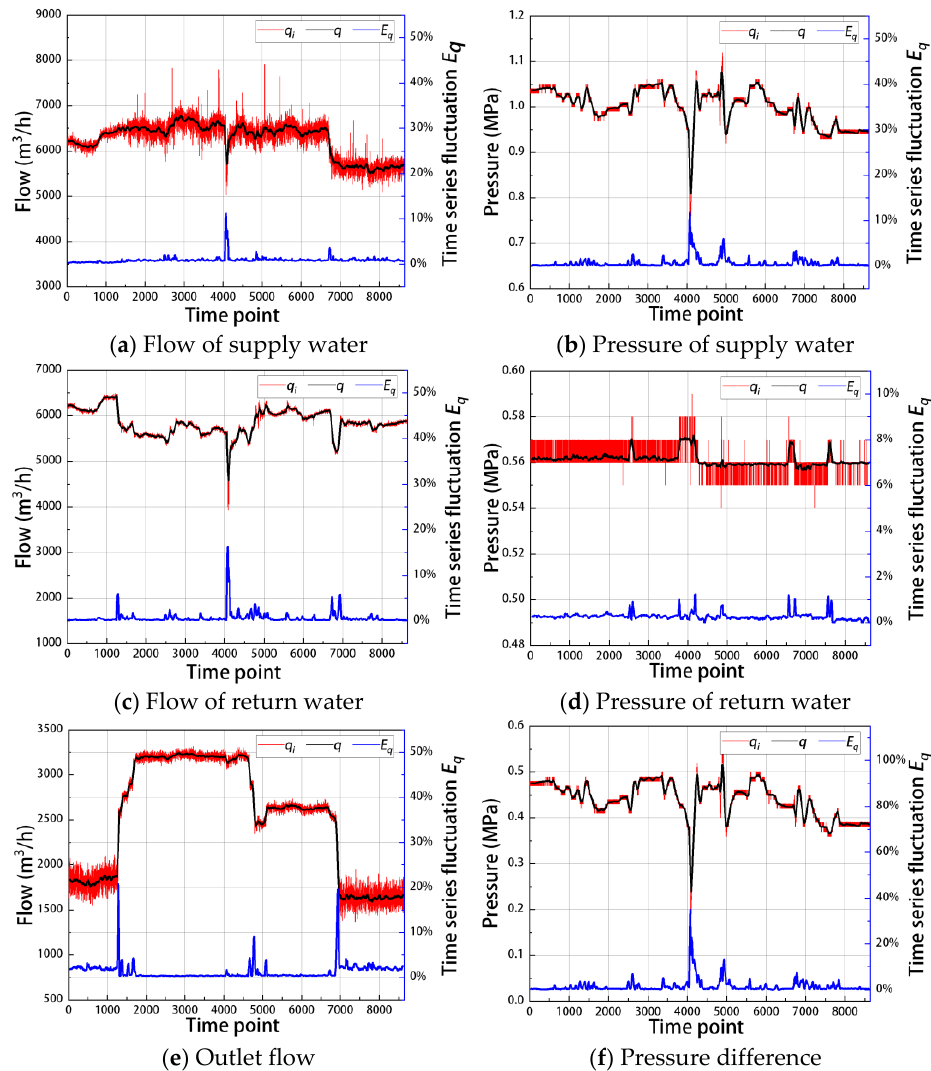
Figure 3. The time-series fluctuation of raw data: ( a ) flow of return water; ( b ) pressure of supply water; ( c ) flow of return water; ( d ) pressure of return water; ( e ) outlet flow; ( f ) pressure difference.